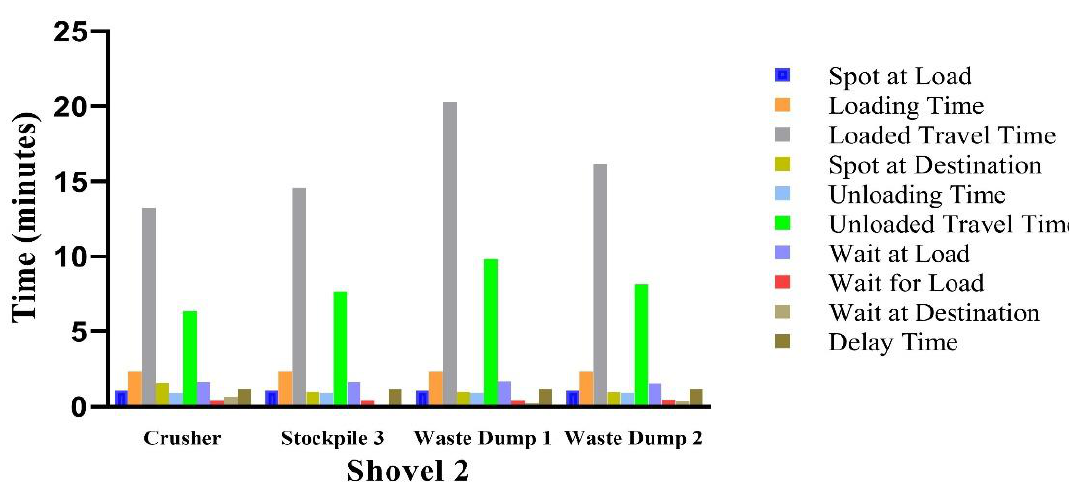
Figure 6. Total cycle time for trucks assigned to shovel 2.